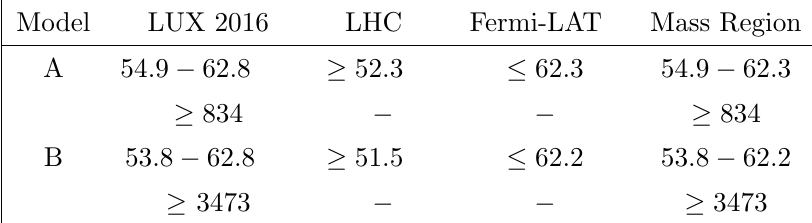
Table 2 . The DM mass bounds for each experiment. The resonant mass and large mass regions in the individual model are